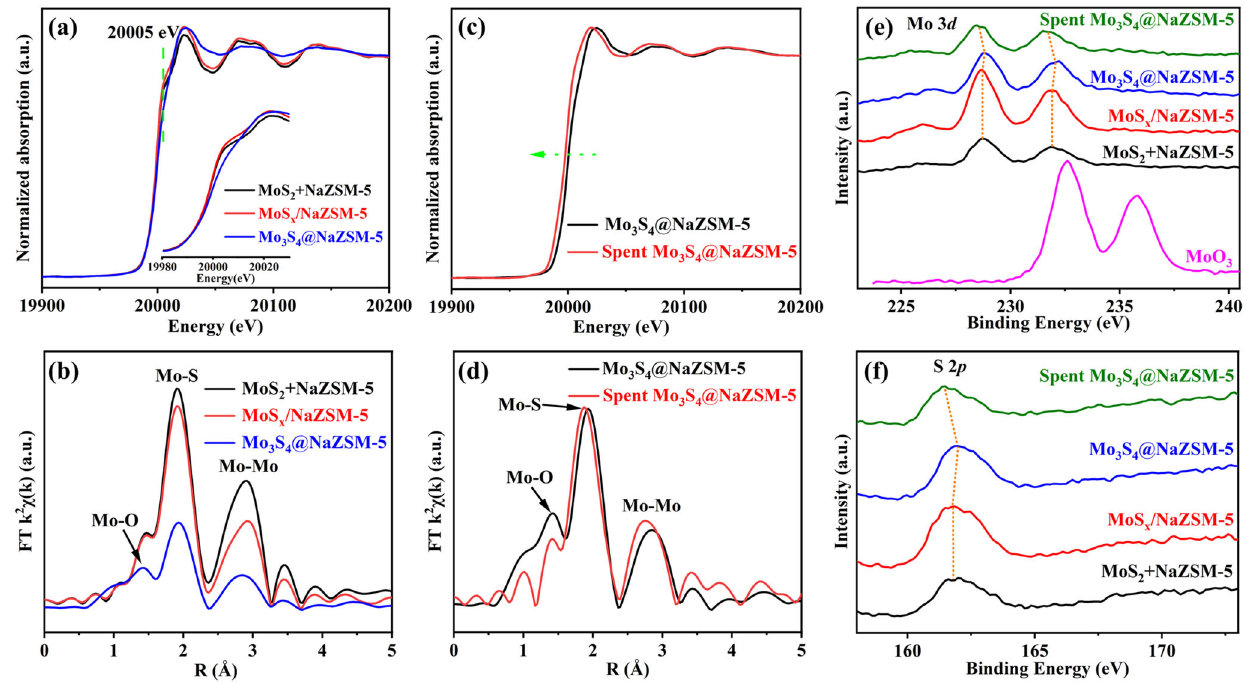
Fig.3|Structureandphysicalpropertyofcatalysts.a X-rayabsorptionnearedge structure (XANES) spectroscopy and b radical distribution functions obtained by Fourier-transformed extended X-ray absorption fi ne structure (EXAFS) spectra of commercial MoS 2 , MoS x /NaZSM-5, and Mo 3 S 4 @NaZSM-5; c XANES spectroscopy and d radical distribution functions obtained by Fourier-transformed EXAFS